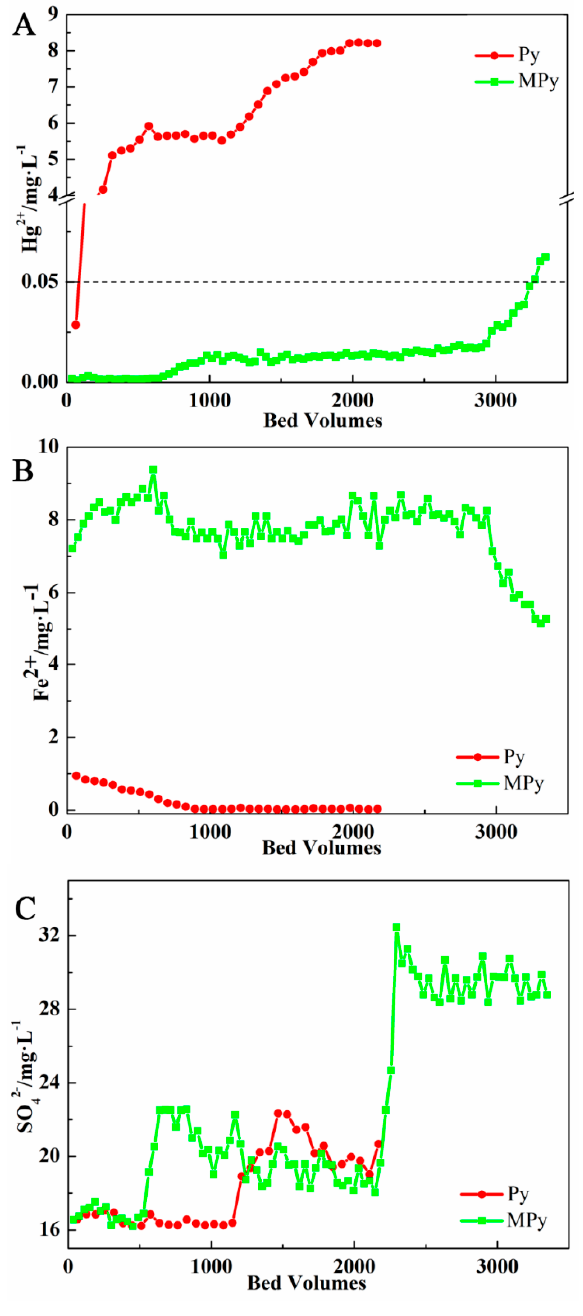
Figure 4. The concentrations of ( A ) Hg(II); ( B ) Fe(II) and ( C ) SO 42 ‐ in the effluent of columns.